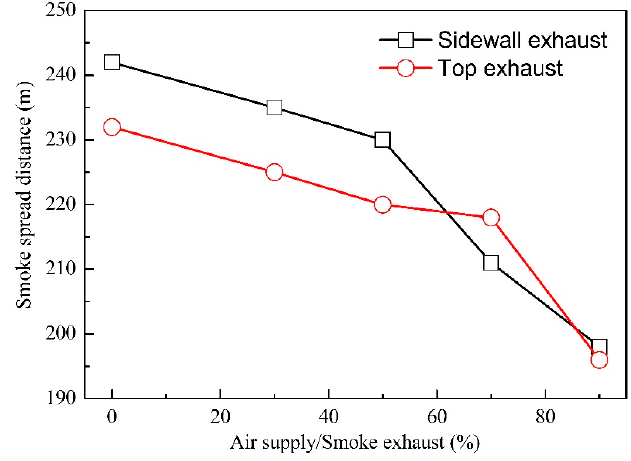
Figure 3. Variation of smoke spread distance with air supply for different smoke exhaust patterns.